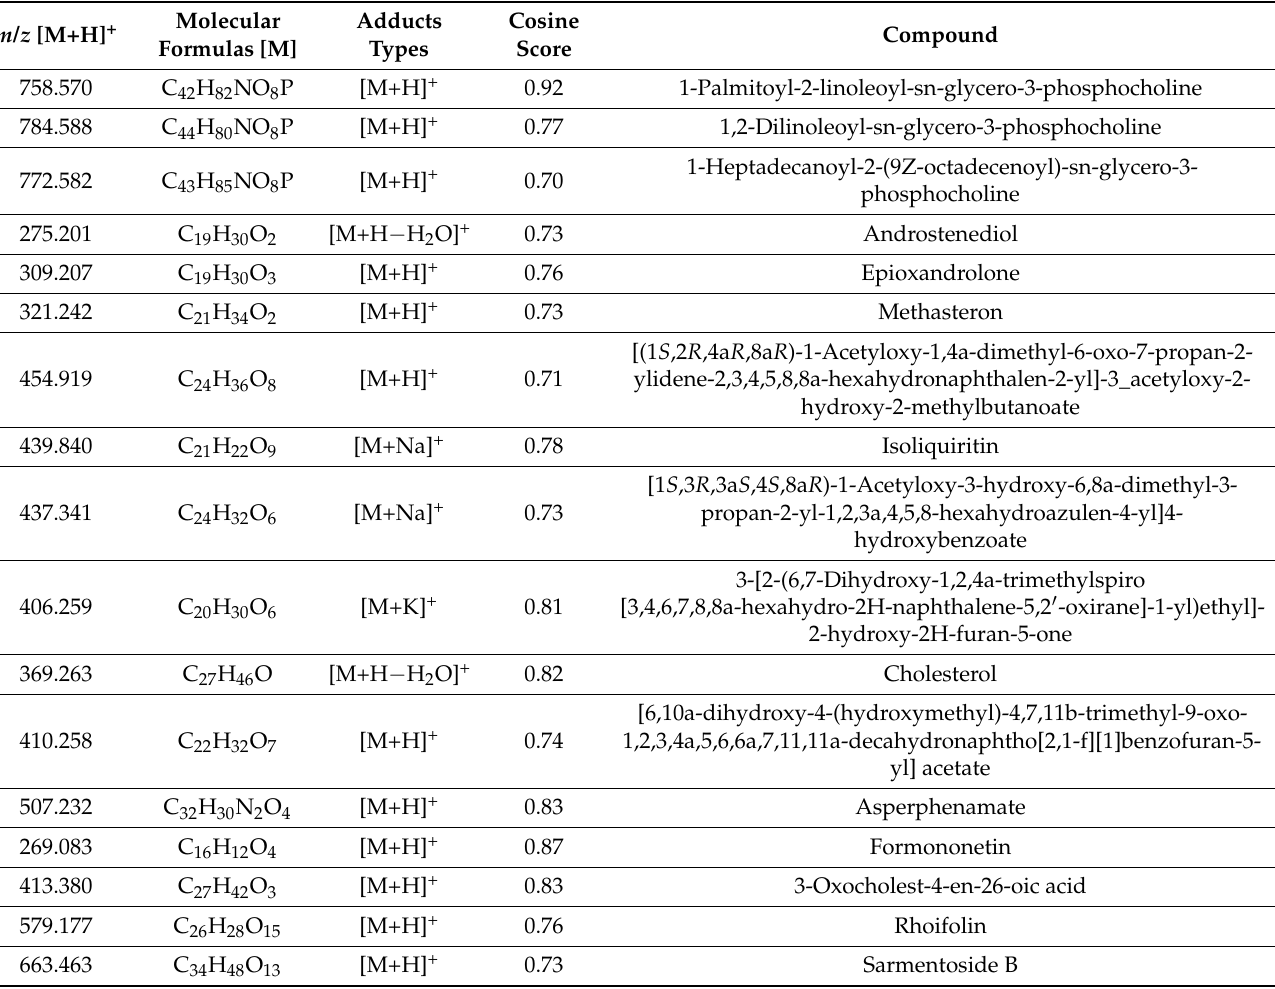
Table 2. Annotated compounds on the molecular networking of E. exsul ethanolic